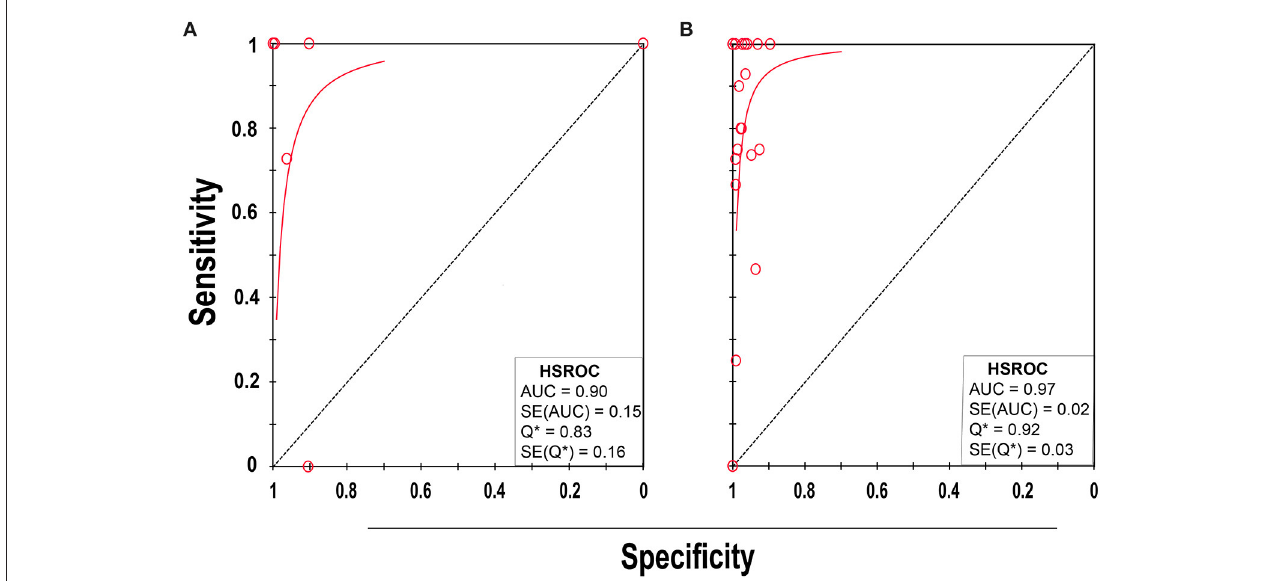
FIGURE 5 | SROC plot of NAAT for (A) pediatric and (B) adult population. Red circles indicate the data point from each of the investigations, and the solid blue line represents the SROC